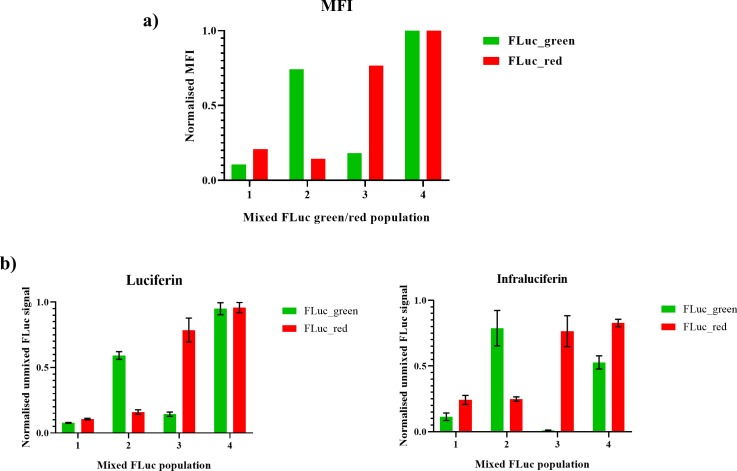
Spectral unmixing of different levels of expressed Fluc_green and Fluc_red in cells with LH2 and iLH2.The mammalian B Lymphoma Raji cell line was transduced with FLuc_green and FLuc_red, which was then sorted by flow cytometry using co-expressed marker genes to get cell populations with differing expression levels of the two luciferases enzymes. (a) The normalised median fluorescence intensity (MFI) of FLuc_green and FLuc_red for each cellular population (b) Differing combinations of low and high expression levels of FLuc_green and FLuc_red could be detemined using spectral bioluminescence imaging and spectral unmixing with both LH2 and iLH2.